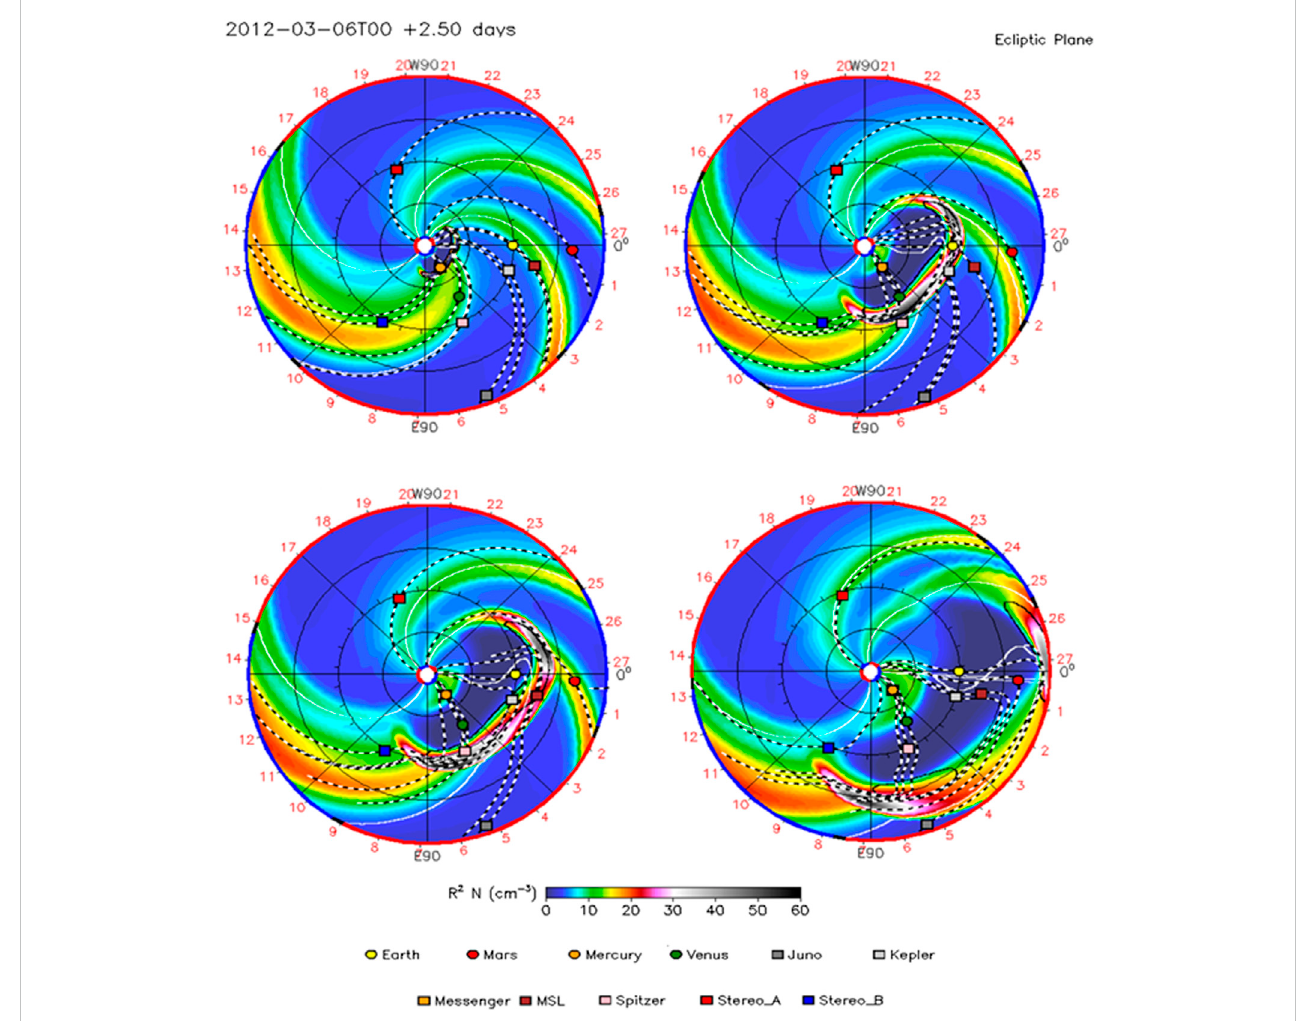
FIGURE 4 WSA-ENLIL + Cone model inner heliospheric simulation snapshots showing the solar wind density (color contour) and interplanetary magnetic fi eld (IMF). The images show the CME arrival at Mercury, Venus, STEREO-B, Earth, and Mars. The scales for the density are given by the color bars at the right side. The relative positions of Mercury, Venus, Earth, Mars, and other spacecraft are indicated with the colored symbols.